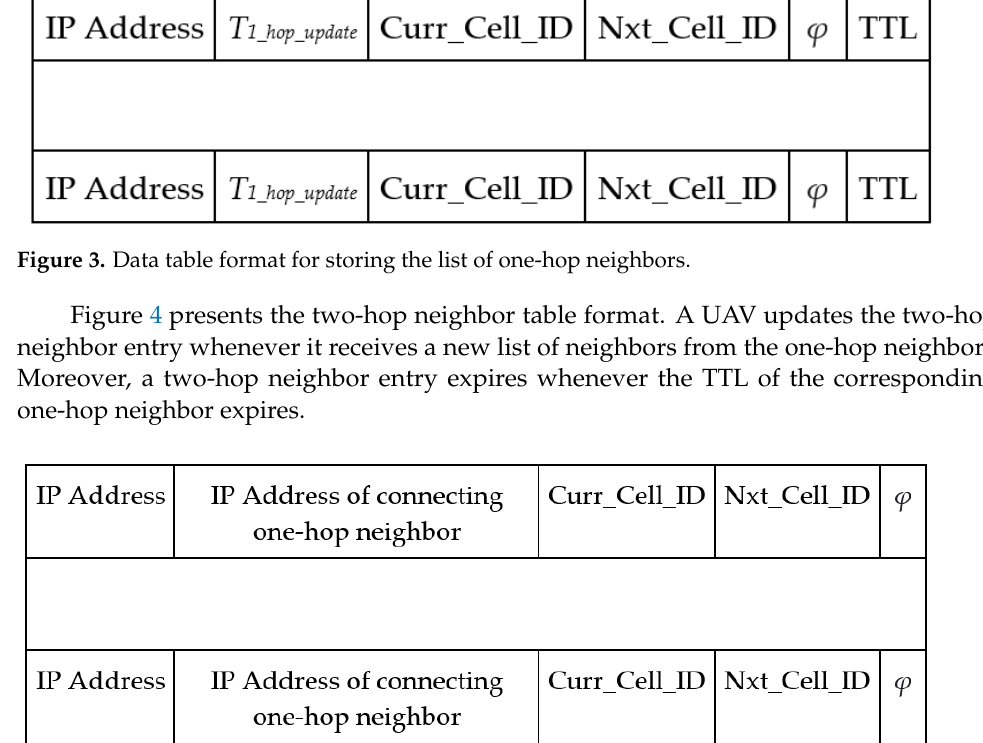
Figure 4. Data table format for storing the list of two ‐ hop neighbors.